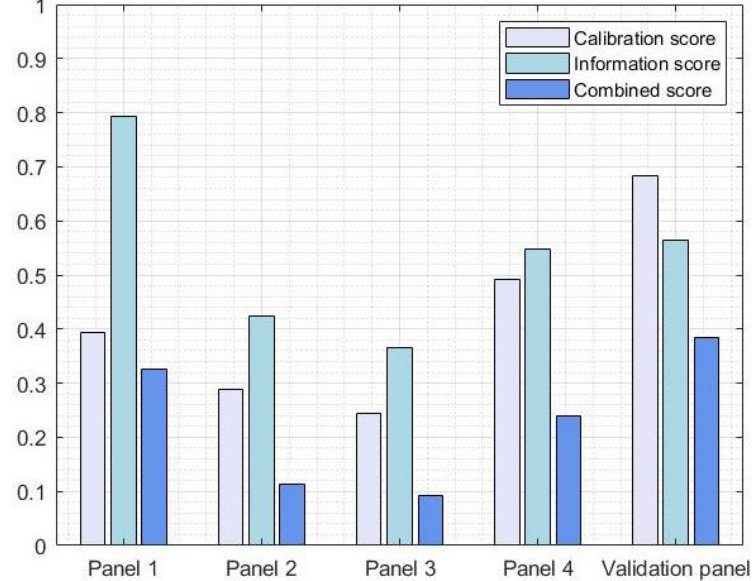
Figure 2. A comparison between scores of the optimized DM’s of the different